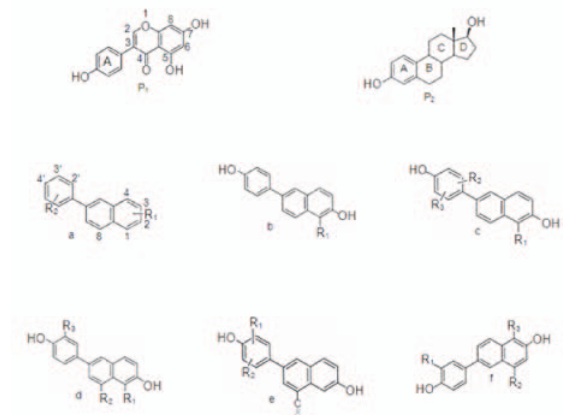
Figure 2. Structures of the 2-phenylnaphthalene scaffold derivatives together genistein and